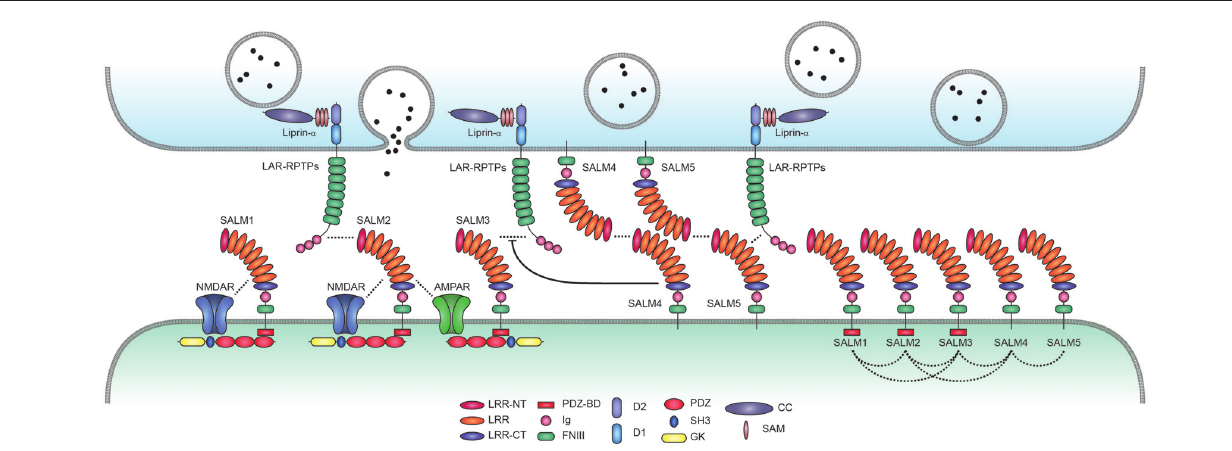
FIGURE 2 | Trans-synaptic, cis-, and cytoplasmic interactions of SALMs. SALMs interact trans-synaptically with presynaptic LAR-RPTPs (LAR, PTP σ and PTP δ ), in cis with AMPA/NMDA receptors and other SALM proteins, and cytoplasmically with the postsynaptic scaffolding protein PSD-95 (in the case of SALMs 1–3 but not SALM4 or SALM5). Protein interactions are indicated by the close proximity of the indicated proteins/domains or by dotted lines. Whether SALMs directly interact with NMDA/AMPA receptors remains to be determined. The trans-synaptic interactions between postsynaptic SALM3/5 and presynaptic LAR-RPTPs are known to promote presynaptic differentiation, although the function of the newly identified SALM2–LAR-RPTP (PTP δ ) interaction is unclear. SALM4 interacts in cis with SALM3 to suppress the binding of SALM3 to presynaptic LAR-RPTPs and SALM3-dependent presynaptic differentiation. Postsynaptic SALM5 can also interacts with presynaptic SALM5 in a homophilic manner, which may interfere with the trans-synaptic interaction between presynaptic LAR-RPTPs and postsynaptic SALM5. The cis-interactions between different postsynaptic SALMs are based on both in vitro and in vivo results, and may be mediated by the SALM–SALM dimerization revealed by X-ray crystallographic studies. Although not shown here, some LAR-RPTPs are thought to be present and function at postsynaptic sites, in addition to presynaptic sites.